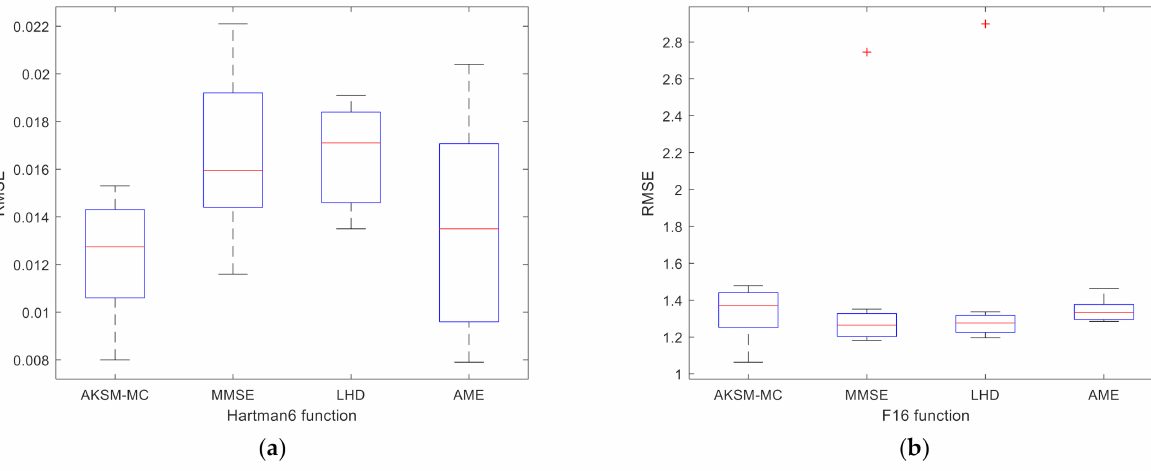
Figure 14. ( a ) Box plot of test results for Hartman6 function; ( b ) Box plot of test results for F16